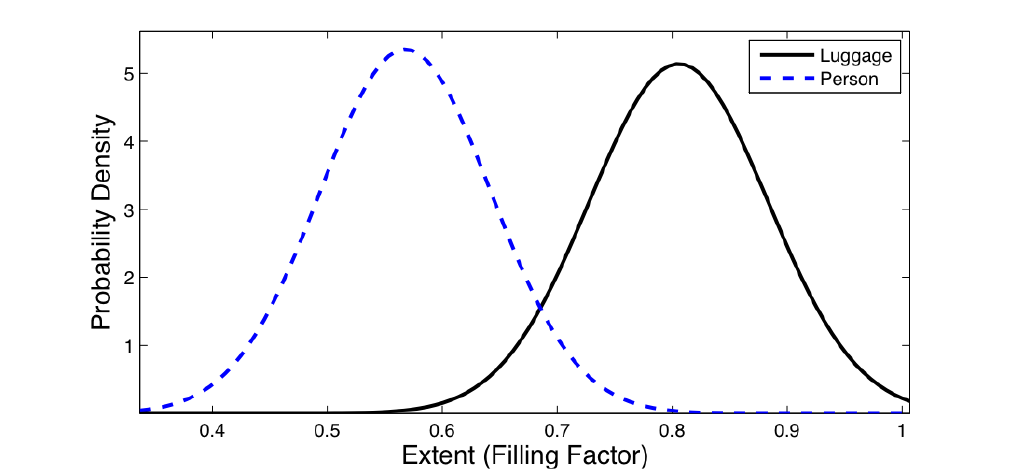
Figure 9. Statistical distributions for Extent feature in Luggage and Person